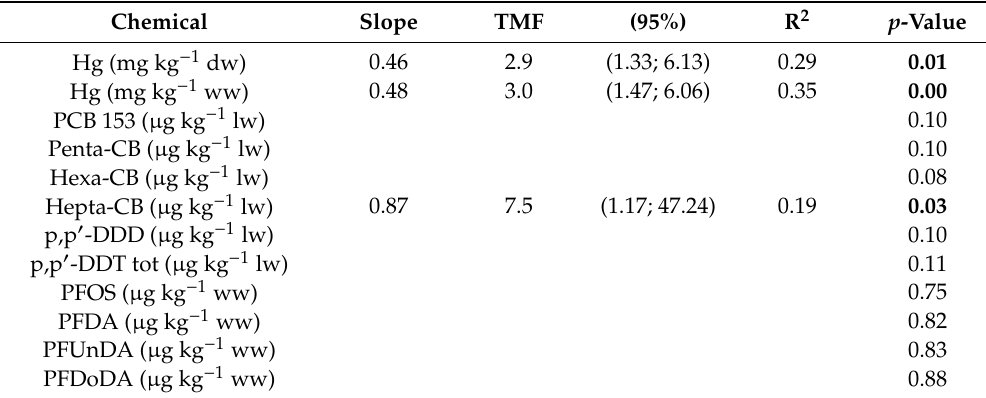
Table 3. Derived TMFs for a fish-only food web (in bold, significant p -values < 0.05). Chemical Slope